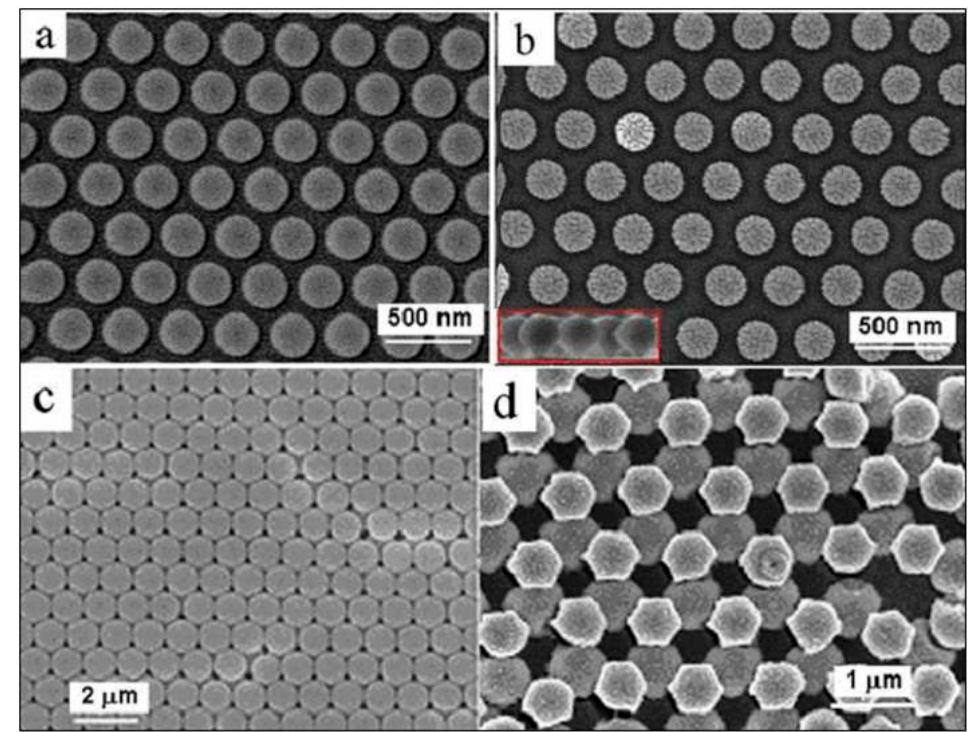
Figure 3. Morphology of the etched PS colloidal crystals. ( a ) and ( b ): The SEM images of PS monolayer colloidal crystals after Ar + plasma etching of the as-prepared monolayer, with 350 nm in the original PS sphere’s diameter, for 5 min and 9 min, respectively. The inset in (b): a local cross sectional image. ( c ): The SEM image of the as-prepared close-packed double-layer PS colloidal crystal with 1 μ m in PS sphere’s diameter. ( d ): The SEM image of (c) after Ar + plasma etching for 12 min. (input power for the etching was 100 W).